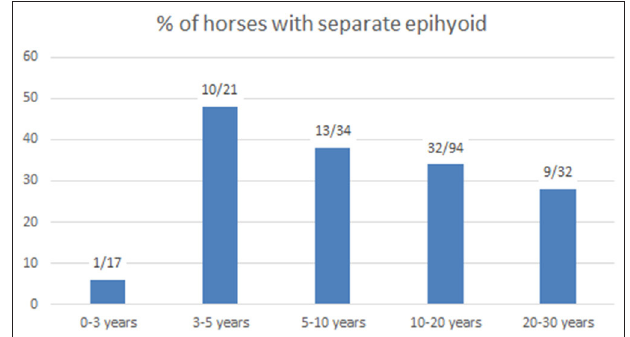
FIGURE 4 | Number of horses with separate epihyoids and percentage in different age